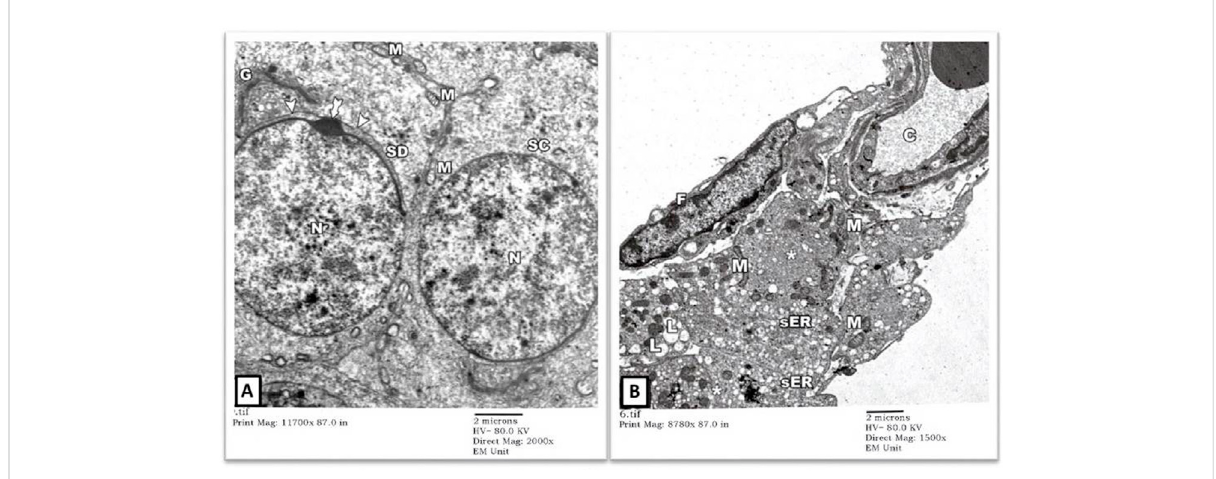
FIGURE 2 An electron micrograph of the testis from a rat in the control group showing: (A) a part of the seminiferous tubule with a spermatocyte (SC) showing rounded nucleus (N) and mitochondria (M). A spermatid (SD) shows a well-developed Golgi apparatus (G). The anterior part of its nucleus is covered by a head cap (arrowheads) and an acrosomal granule (tailed arrow). (Uranyl acetate and lead citrate X 2000, Print Mag. X 11700). (B) the testicular interstitium with blood capillaries (C), fi broblasts (F), and Leydig cells (asterisks). The cytoplasm of Leydig cells contains numerous mitochondria (M), vesicles of sER, and lipid droplets (L). (Uranyl acetate and lead citrate X 1500, Print Mag. X 8780).